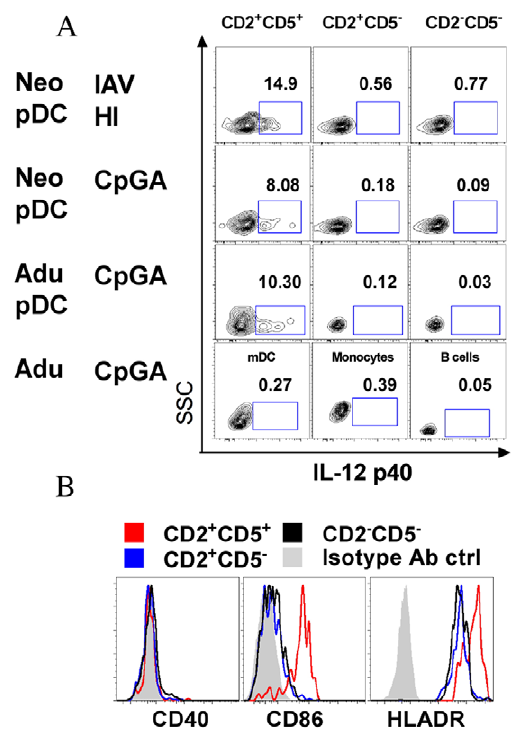
Figure 5. IL-12p40 producing pDCs represent a small subset of CD2 + pDC. (A) Neonatal and Adult MNCs were stimulated with IAV-HI CpGA then CD2 + CD5 + , CD2 + CD5 2 and CD2 2 CD5 2 pDCs subsets were gated to analyze their capacity to produce IL-12 p40 detected by intracellular cytokine staining. CpGA stimulated mDC (BDCA1 + CD20 2 CD14 2 ), monocytes (CD14 + ) and B cells (CD20 + ) from adult PBMC were also stained for IL-12p40 intracellularly. Numbers indicate the percentage of cytokine-producing cells among totally gated cells. (B) Expression of co-stimulatory markers CD40, CD86 and HLADR on neonatal BDCA4 + CD123 + pDCs defined as CD2 + CD5 + , CD2 + CD5 2 and CD2 2 CD5 2 subsets under steady state. Data are representative of 3